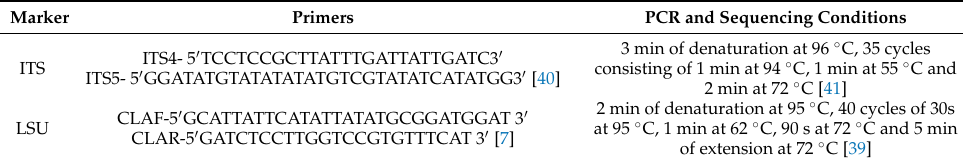
Table 1. Primers used for PCR and sequencing of Escovopsis